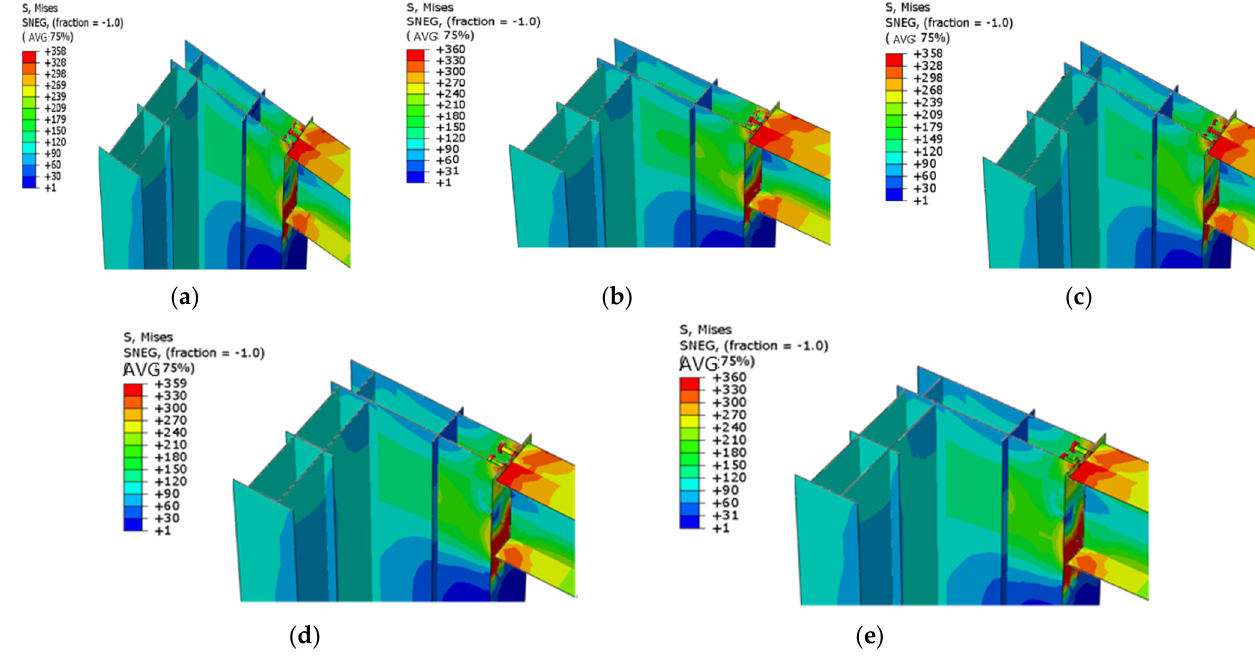
Figure 8. Mises stress cloud (unit: MPa). ( a ) S ‐ 1; ( b ) S ‐ 2; ( c ) S ‐ 3; ( d ) S ‐ 4; ( e ) S ‐ 5.